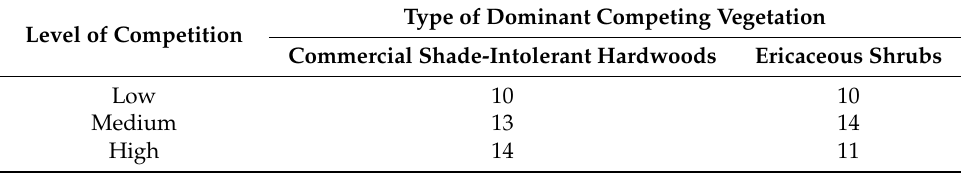
Table 1. Distribution of transects in the stratified inventory based on dominance by competing vegetation groups and levels of competition. Type of Dominant Competing Vegetation Level of Competition Commercial Shade-Intolerant Hardwoods Ericaceous Shrubs Low 10 10 Medium 13